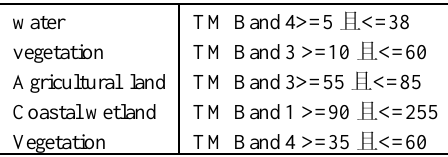
Table 5. Decision rules